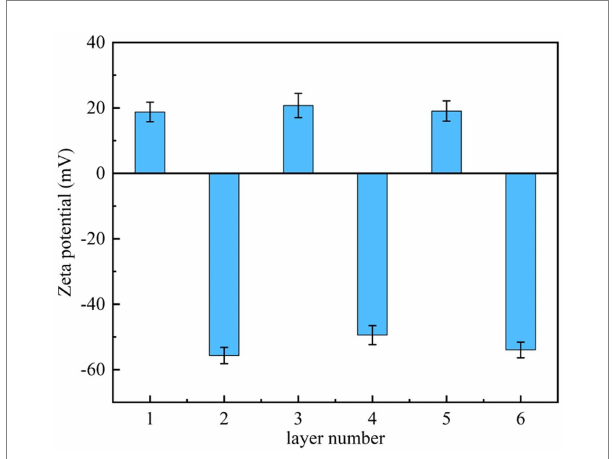
FIGURE 1 The surface Zeta-potential of SiO 2 microparticles after the deposition of each